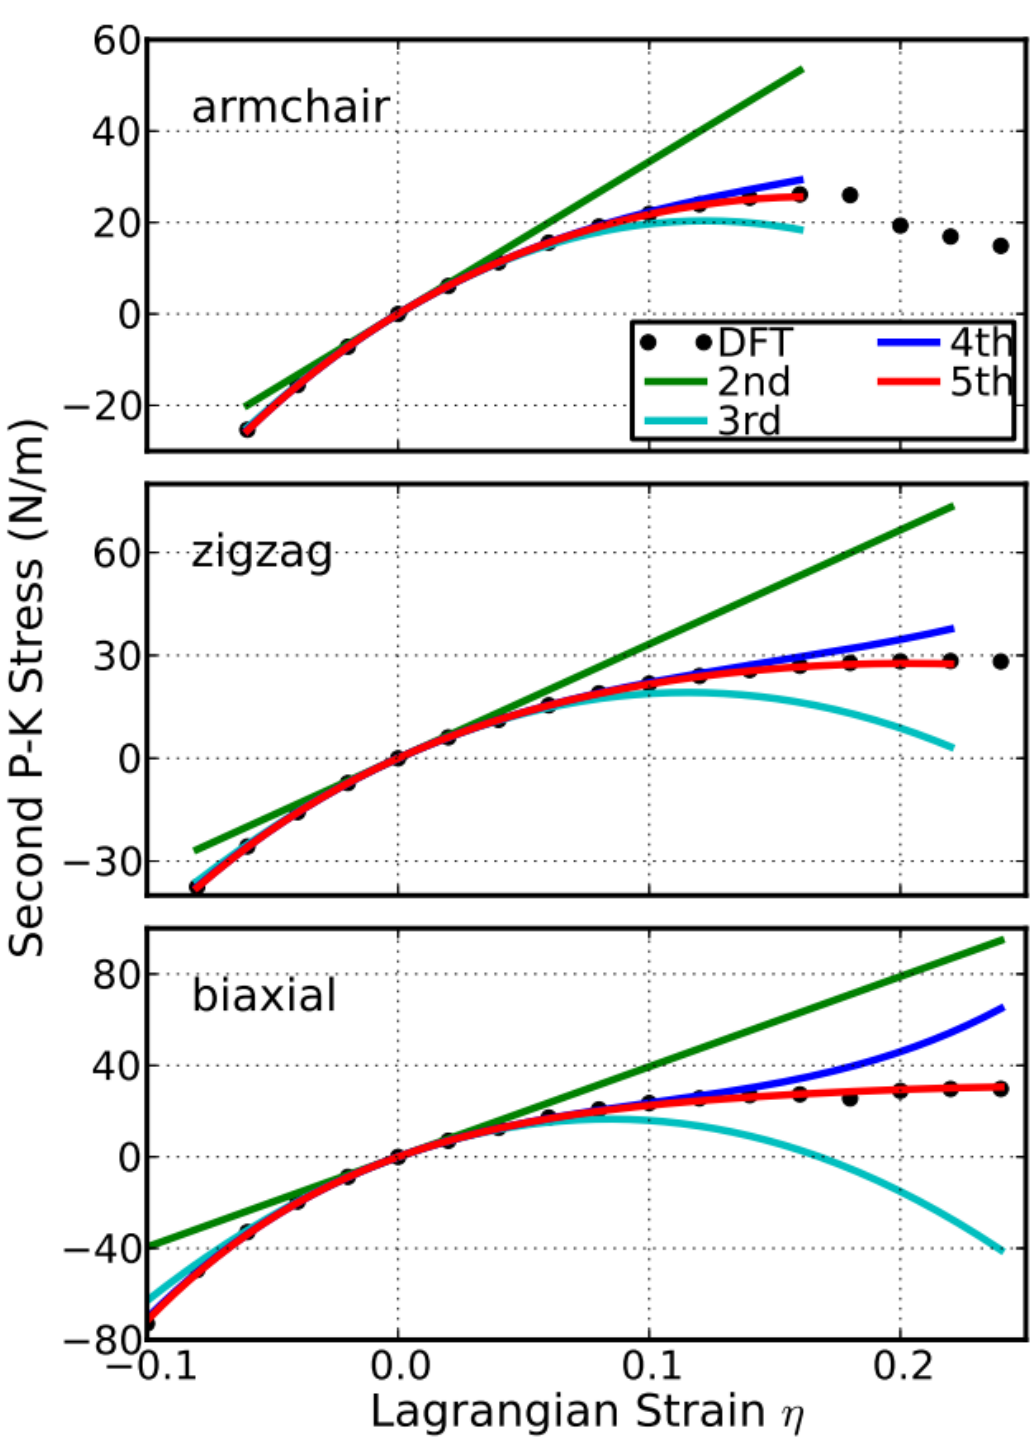
Figure 8. Predicted stress–strain responses from different orders: second, third, fourth, and fifth order, and compared to the DFT calculations in the three deformation directions of C BN = 0.25.